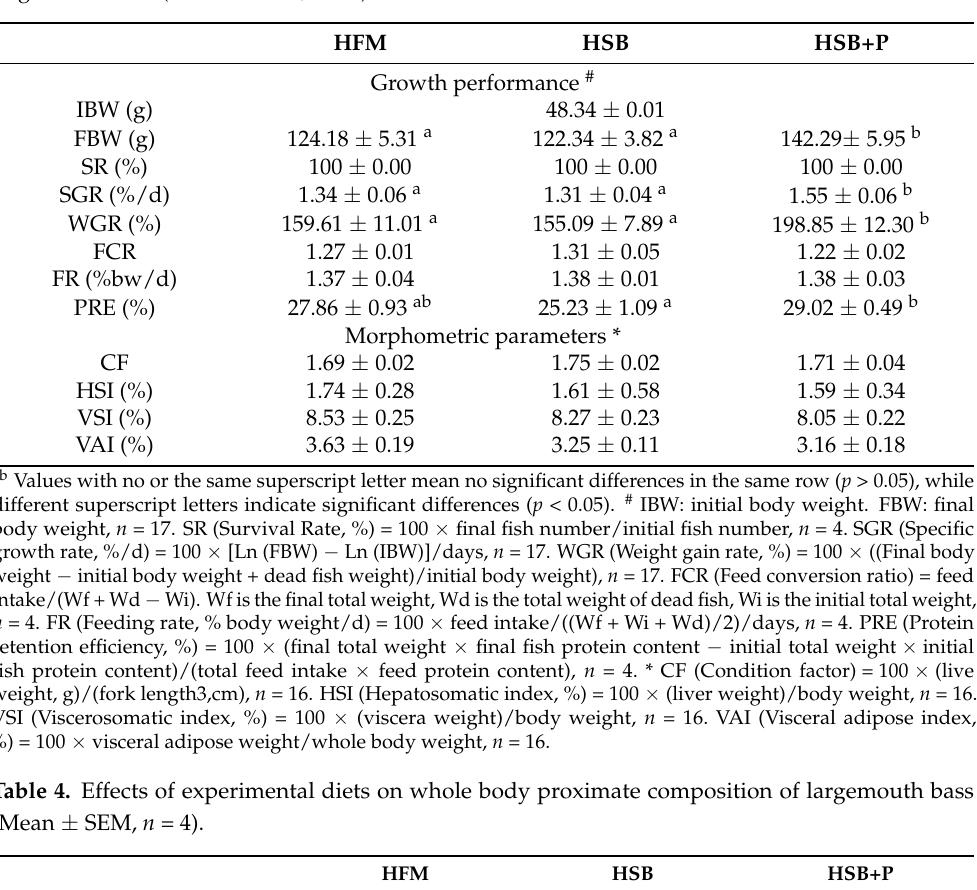
Table 3. Effects of experimental diets on growth performance and morphometric parameters of largemouth bass (Mean ± SEM, n = 4).